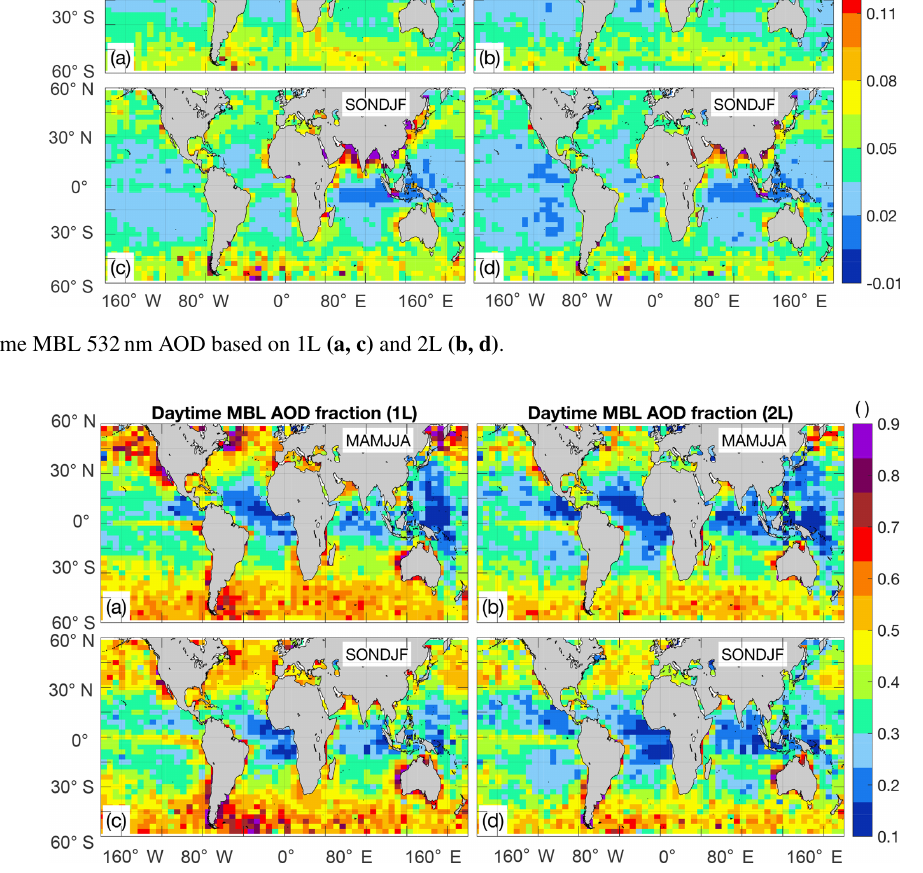
Figure 14. Fraction of daytime AOD contributed by the marine boundary